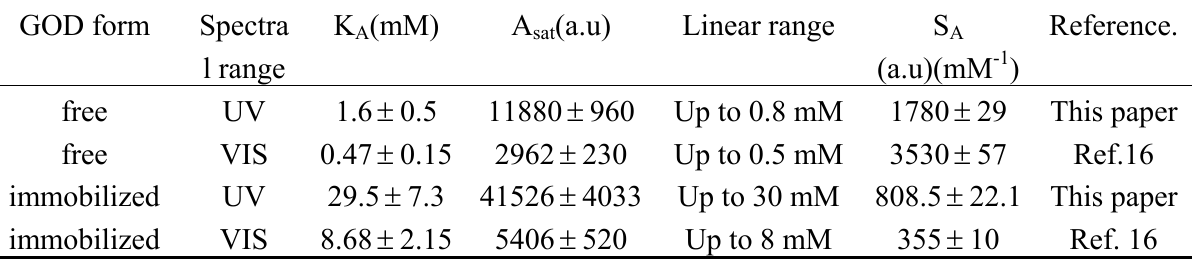
Table 2. Optokinetic parameters from fluorescence area integral analysis for free and immobilized GOD evaluated from UV and visible emission spectra measurements.